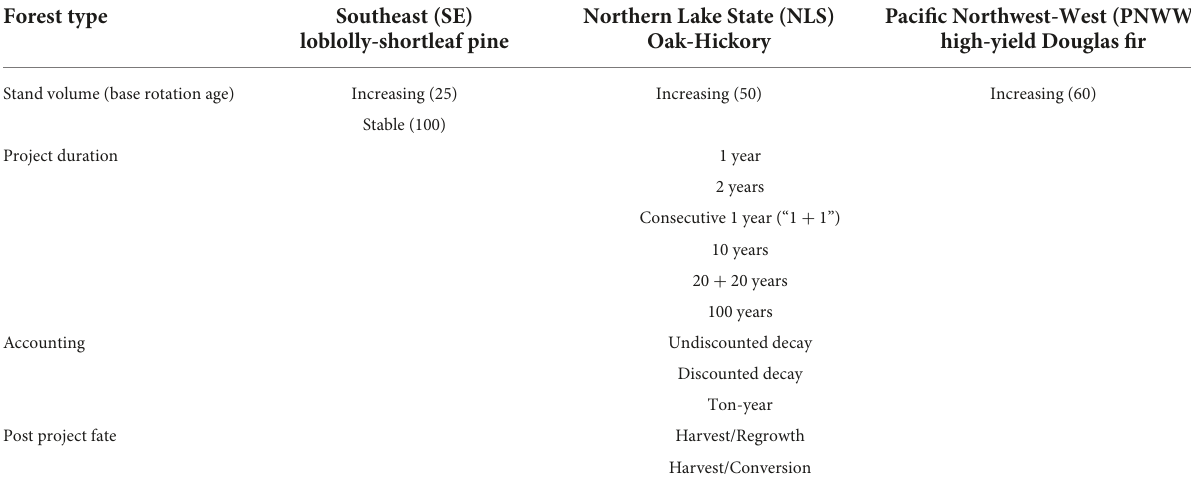
TABLE 1 Array of project configurations considered in the following